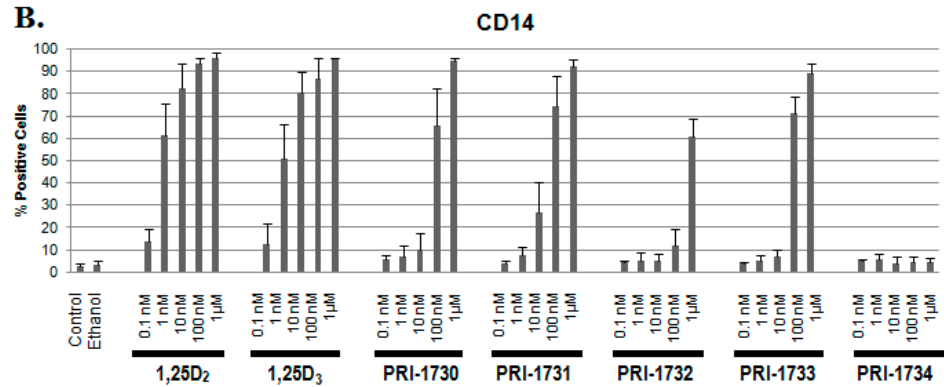
Figure 3. Preliminary screening of pro-differentiating activities of analogues studied. HL60 cells were exposed to 1,25D 2 , 1,25D 3 and analogues at concentrations of: 0.1, 1, 10, 100 nM, and 1 μ M. The expression levels of both ( A ) CD11b and ( B ) CD14 were studied. Percentages of positive cells are presented in the y -axis.